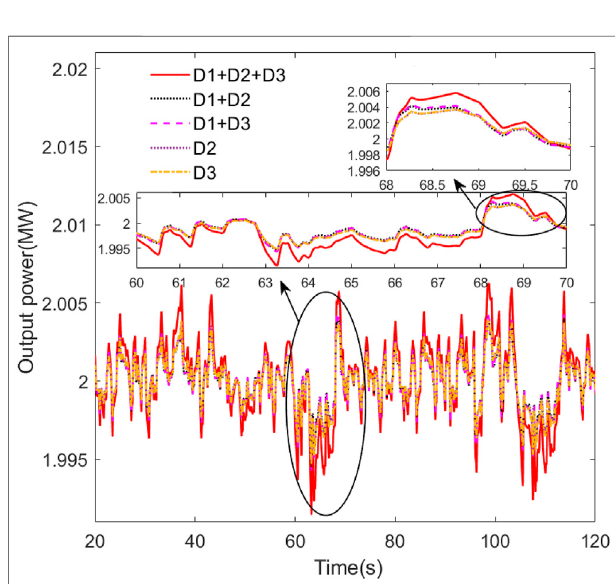
FIGURE 19 | Comparison curves of wind turbine output power under different